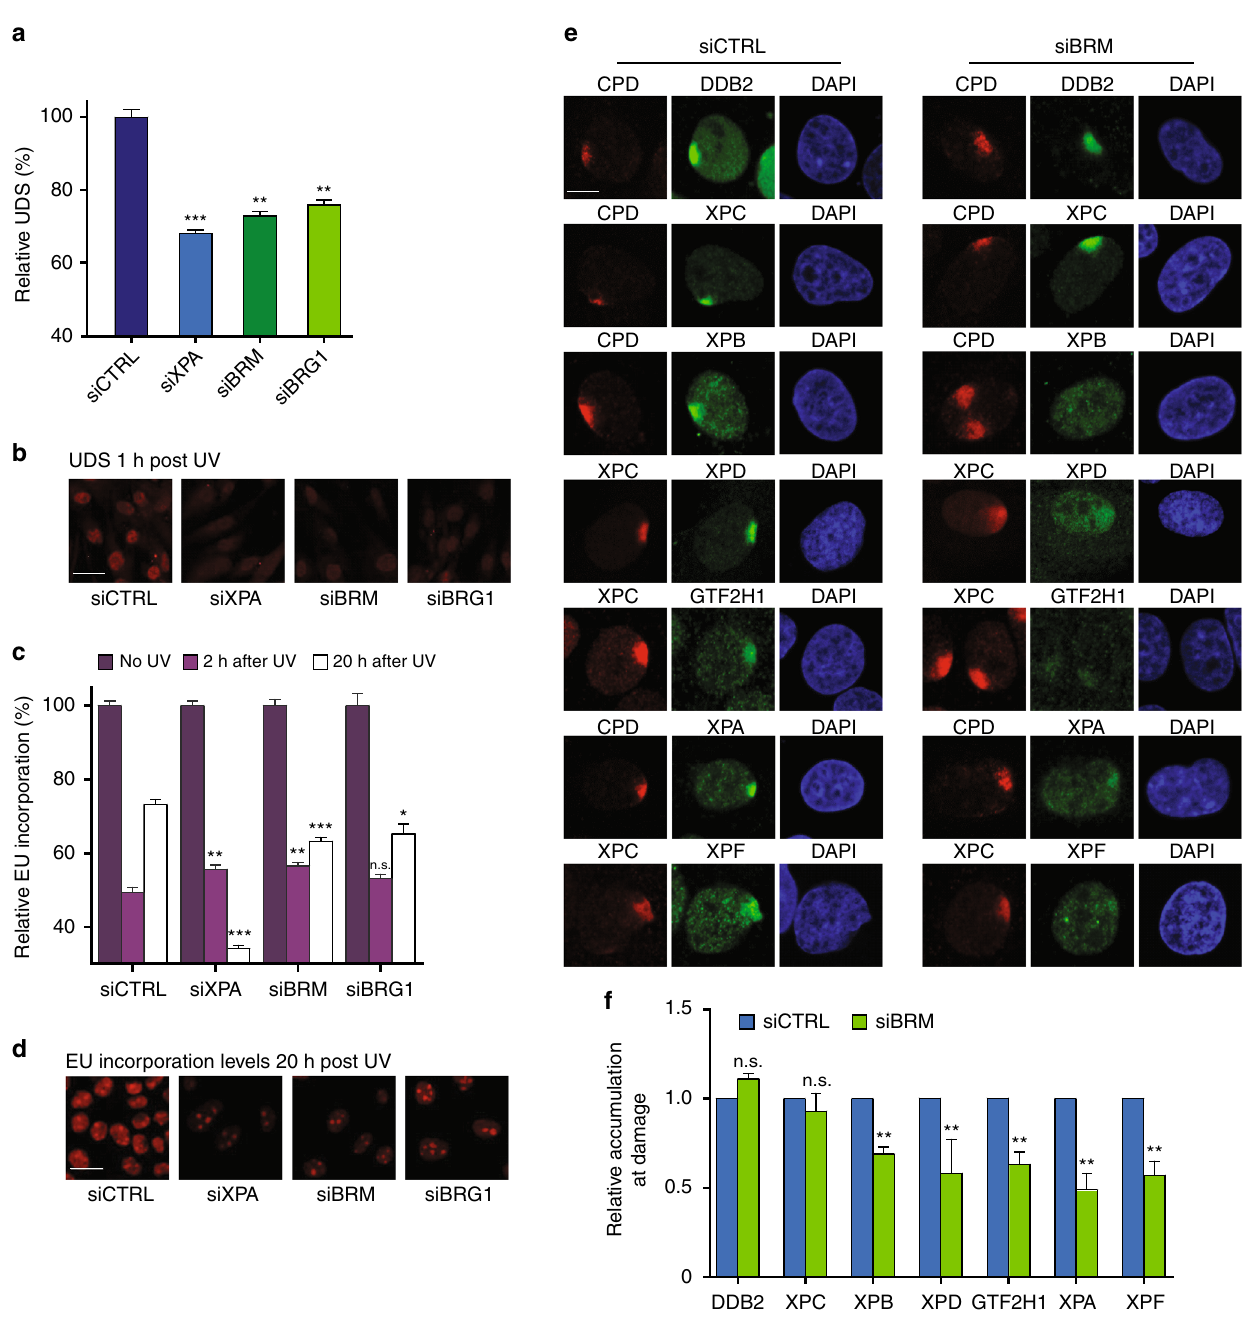
Fig. 1 SWI/SNF is required for ef fi cient NER. a Quanti fi cation of unscheduled DNA synthesis (UDS) in C5RO primary fi broblasts treated with non-targeting control (CTRL), XPA, BRM, and BRG1 siRNAs (Supplementary Fig. 1a). UDS was determined by EdU incorporation for 1 h after UV-C (16 J/m 2 ) irradiation followed by fl uorescent staining of the incorporated EdU. Fluorescence was quanti fi ed and normalized to control, set to 100%. Mean & S.E.M. of > 200 cells per sample from two independent experiments. ** P < 0.01, *** P < 0.001, relative to siCTRL. b UDS representative pictures, 1 h after UV-C. Scale bar: 25 µ m. c Quanti fi cation of recovery of RNA synthesis (RRS) in U2OS cells treated with non-targeting control (CTRL), XPA, BRM, and BRG1 siRNAs (Supplementary Fig. 1b). Transcription levels in non-irradiated cells and in cells 2 and 20 h after UV-C irradiation (6 J/m 2 ) were determined by a 2 h pulse- labeling with the uridine analogue EU and subsequent fl uorescent staining and measurement of incorporated EU. RRS levels were normalized to non- irradiated cells, set to 100%. Mean and S.E.M. of > 200 cells per condition from at least two independent experiments. * P < 0.05, *** P < 0.001, relative to each siCTRL in each time point. d RRS representative pictures, 20 h after UV-C irradiation. Scale bar: 25 µ m. e Immuno fl uorescence (IF) showing recruitment of the indicated NER proteins (green channel) to local UV-C damage (LUD) in U2OS cells treated with control or BRM siRNAs (Supplementary Fig. 1c). Cells were fi xed 30 min after inducing LUD with UV-C irradiation (60 J/m 2 ) through a microporous membrane (8 µ m). UV lesions were marked with staining against CPD or XPC, red channel. DNA was stained with DAPI. Scale bar: 5 µ m. f Quanti fi cation of NER proteins recruitment to LUD. Relative accumulation at LUD (over nuclear background) after siBRM was normalized to control, in which nuclear background was set at 0 and maximal signal at LUD set to 1.0 for each protein. Mean and S.E.M. of > 100 cells per sample, of at least two independent experiments, except for GTF2H1 which was only performed once. ** P < 0.01, relative to siCTRL, n.s. non-signi fi